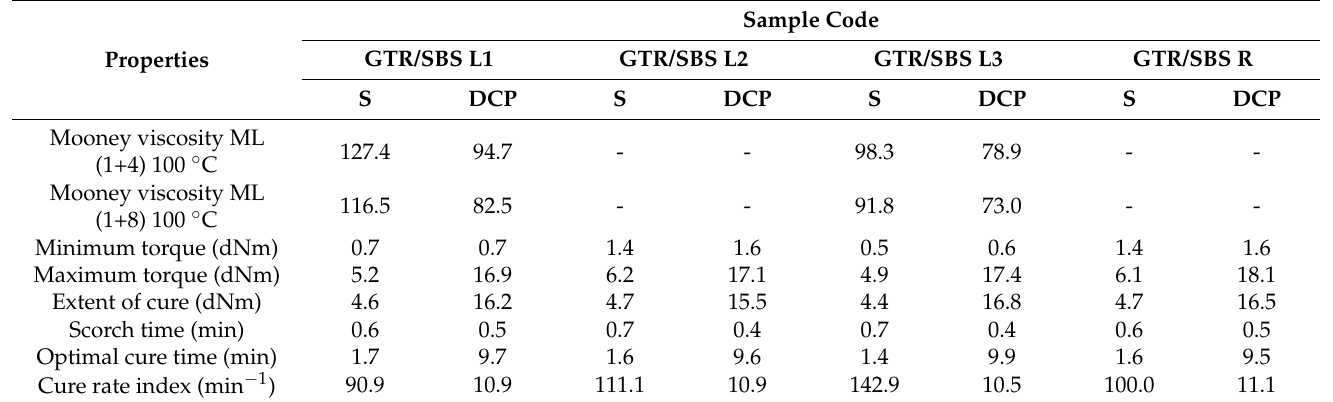
Table 2. Curing characteristics of the studied samples performed at 170 ◦